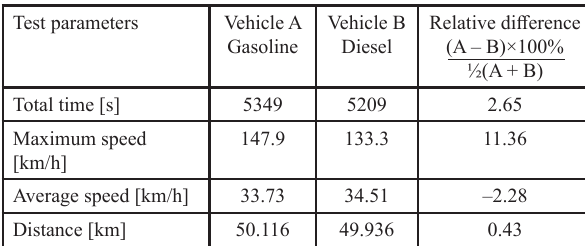
Table 2. Test route characteristics